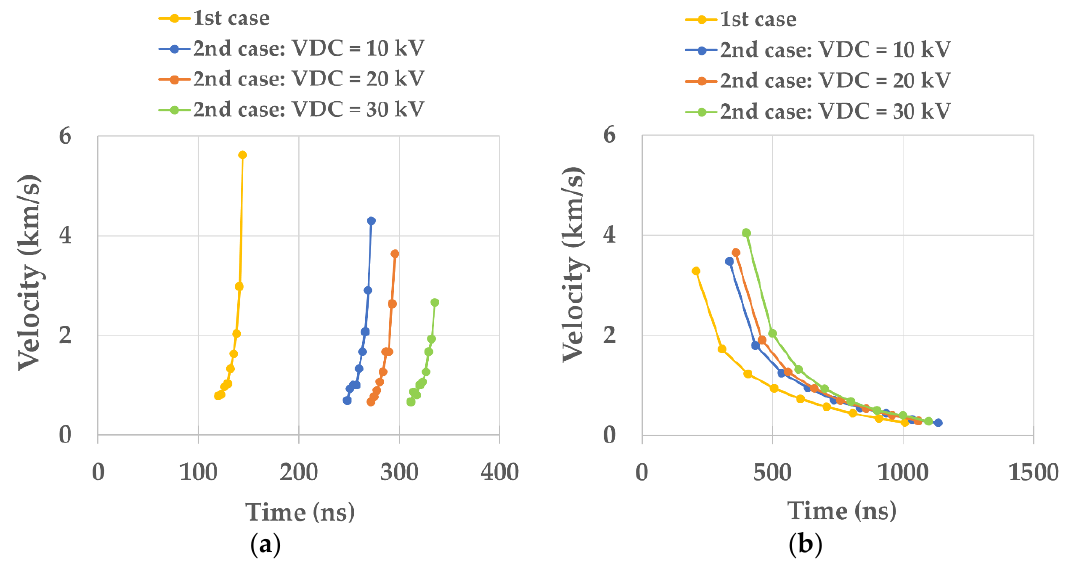
Figure 16. Streamer velocity (km/s) as a function of time (s) in the 1st and 2nd cases: ( a ) streamer propagation in oil; ( b ) streamer travel along the oil–OIP interface.